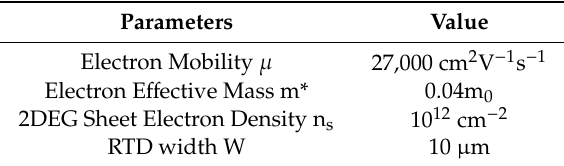
Table 1. Structural parameters in the transmission line